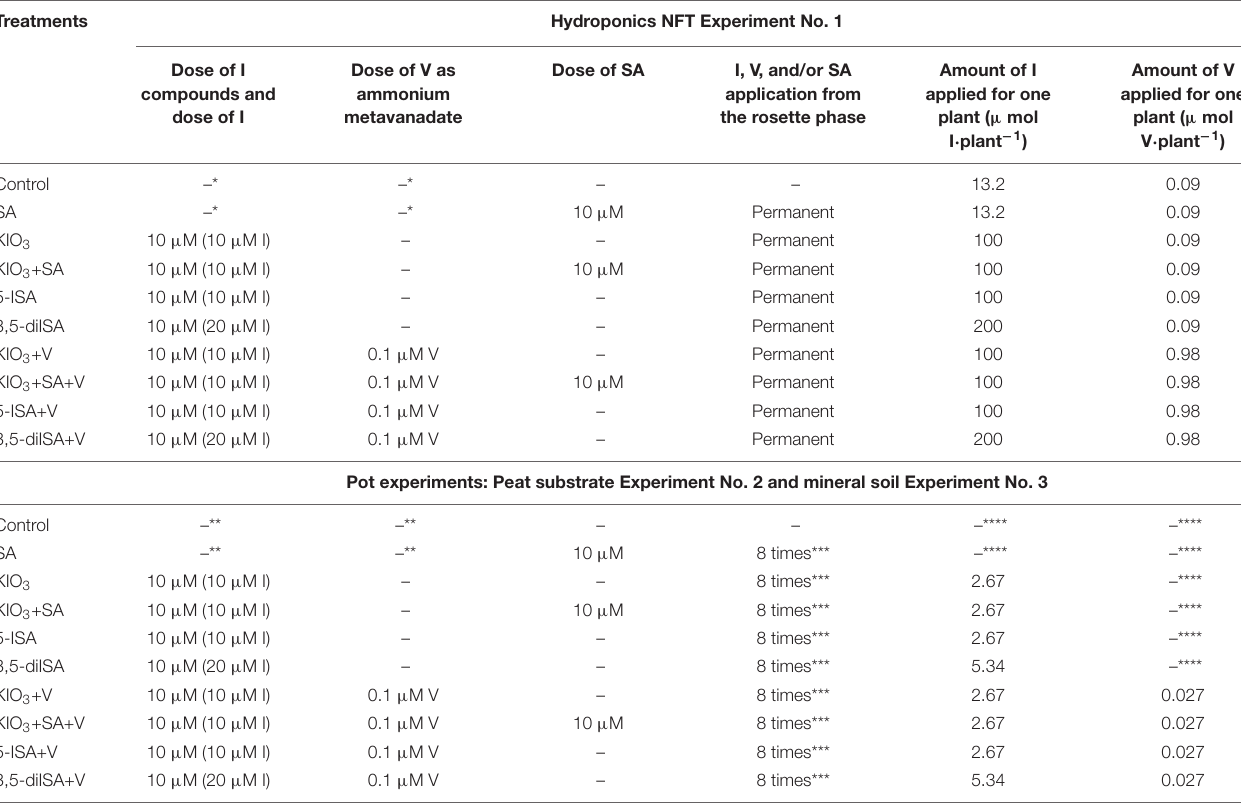
TABLE 1 | Design and method of conducting experiments with lettuce cultivation in the hydroponics NFT Experiment No. 1 as well as in pot experiments: Experiment Nos. 2 and 3.